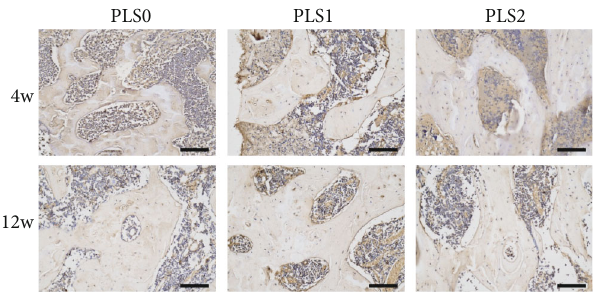
Figure 7: Histopathological CD31 staining demonstrating the formation of blood vessels in the femoral head